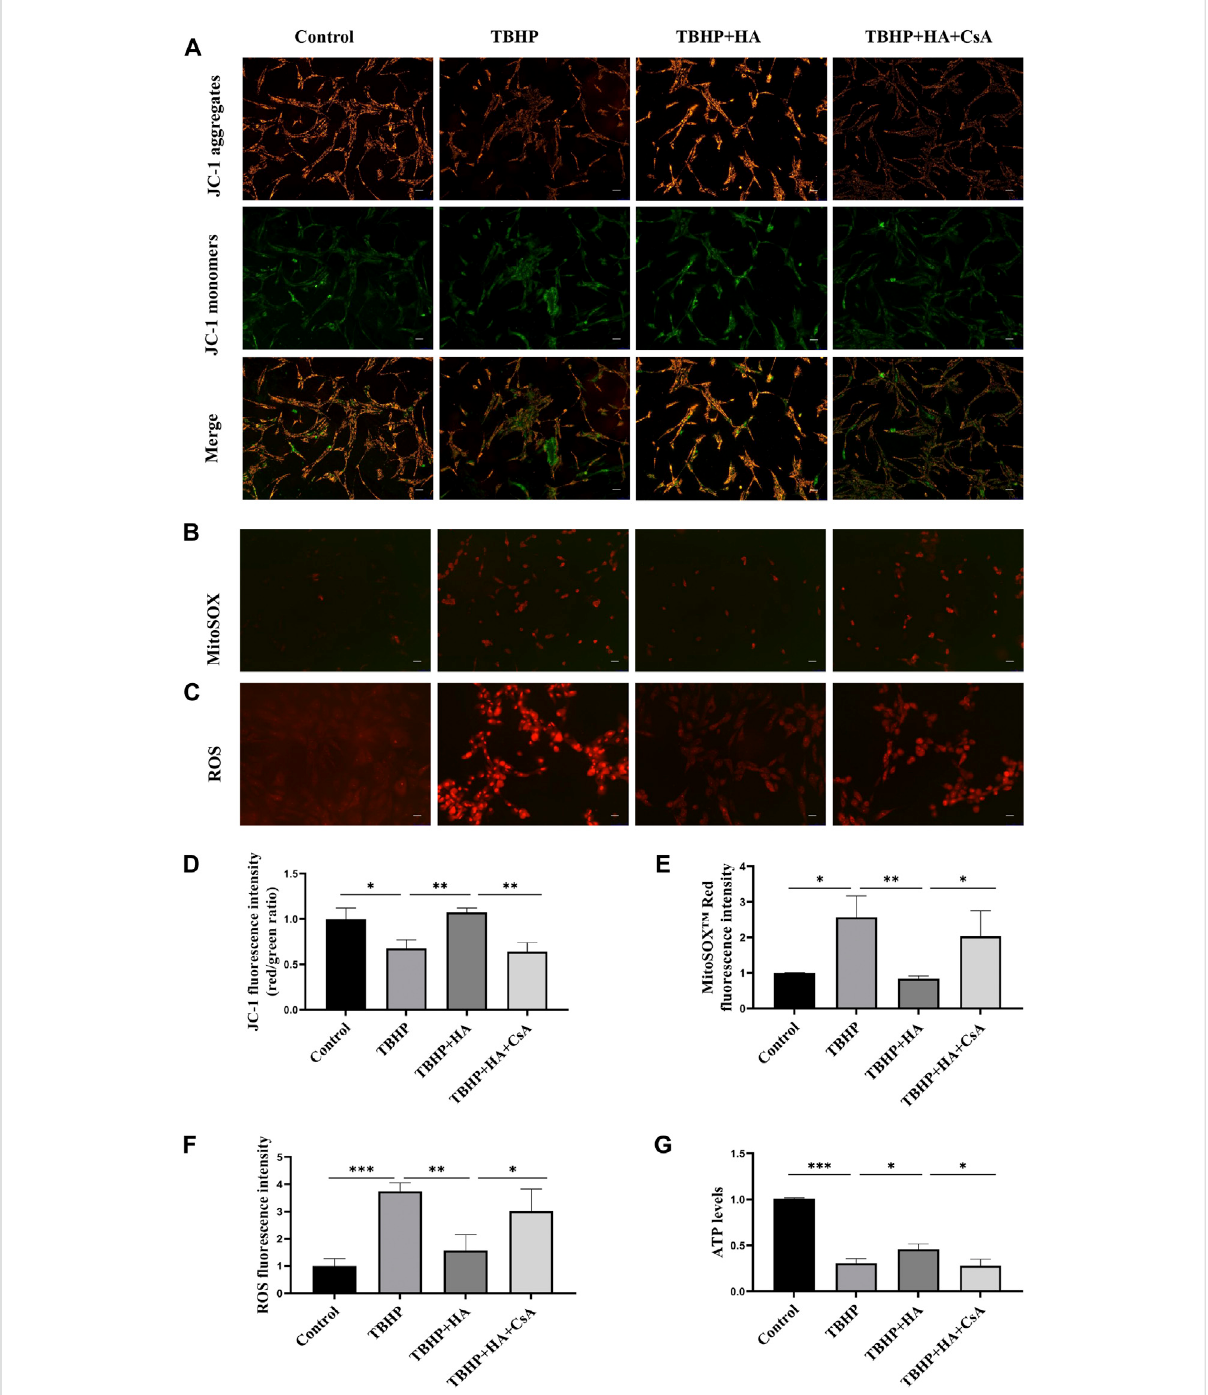
FIGURE 2 HA attenuates TBHP-induced mitochondrial dysfunction in NPCs. (A) Δψ m in NPCs was measured by JC-1 staining. (B) The production of mitochondrial Superoxide was measured by using MitoSOX ™ Red Superoxide Indicator. (C) The production of ROS was tested by DHE staining. (D – F) Therelative fl uorescenceintensitywasmeasuredusingImageJsoftware. (G) CellularATPlevelsofNPCsweremeasured.Dataarerepresented as the mean ± SD. * p < 0.05, ** p < 0.01, *** p < 0.001. Scale bar: 50 μ m n =